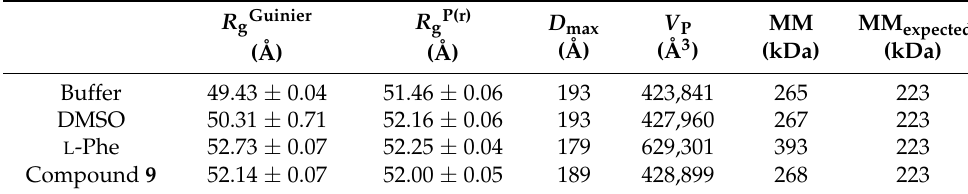
Table 2. Small-angle X-ray scattering (SAXS) structural parameters of human phenylalanine hydrox- ylase